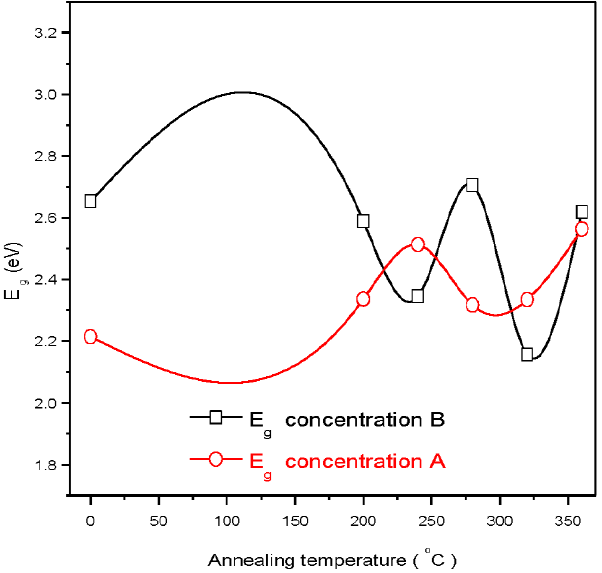
) at different annealing g